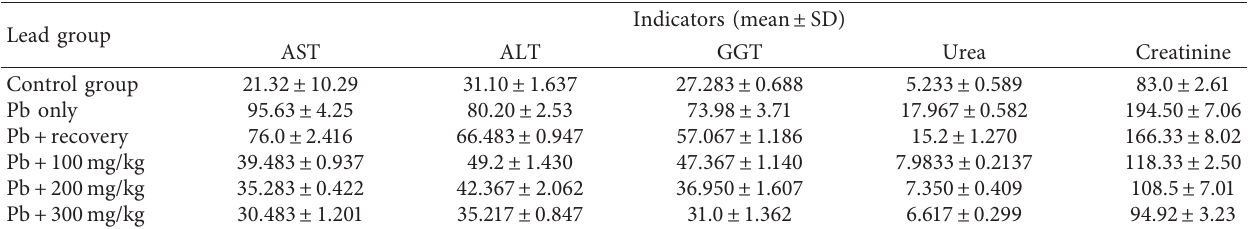
Values are presented as mean ± SD. P value < 0.05 is statistically significant.